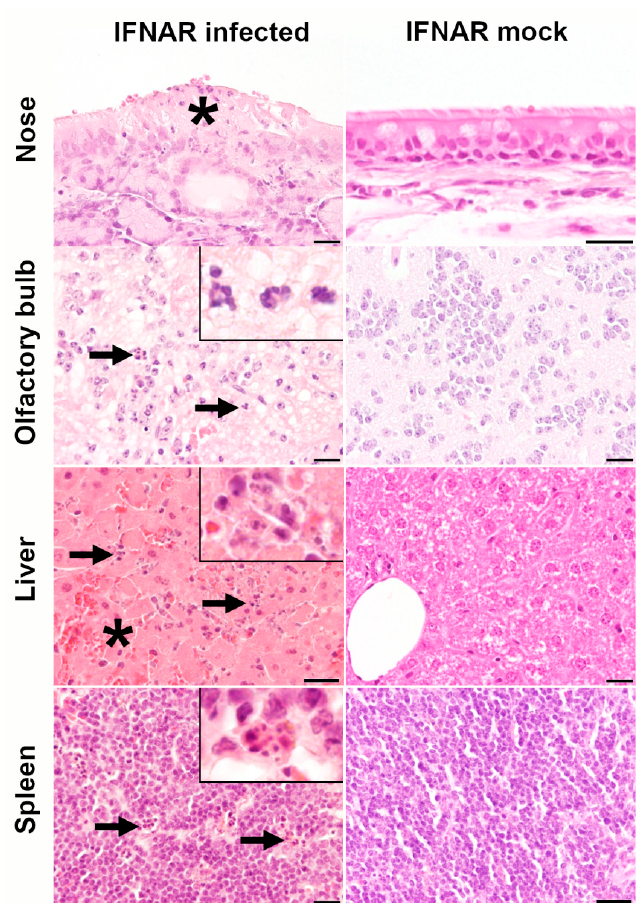
Figure 3. Histological findings in the olfactory epithelium, olfactory bulb, liver, and spleen of type I interferon receptor knockout (IFNAR − / − ) mice infected with Rift Valley fever virus (RVFV). Infected mice are shown in the left column and mock-infected control mice in the right column. Mild necrosuppurative inflammation of the respiratory mucosa (asterisk) in an IFNAR − / − mouse at 5 days post infection (dpi) with 10 3 plaque-forming units (PFU) RVFV. Mild neuronal necrosis (arrows; inset) in the olfactory bulb of an IFNAR − / − mouse at 2 dpi with 10 3 PFU RVFV. Moderate hepatocellular necrosis (arrows; inset) and hemorrhage (asterisk) in the liver of an IFNAR − / − mouse at 5 dpi with 10 3 PFU RVFV. Multifocal lymphocytolysis (arrows, inset) in the spleen of an IFNAR − / − mouse at 3 dpi with 10 3 PFU RVFV. No lesions were present in mock-infected control animals sampled at 21 dpi. Hematoxylin and eosin staining, Bars = 20 µm.